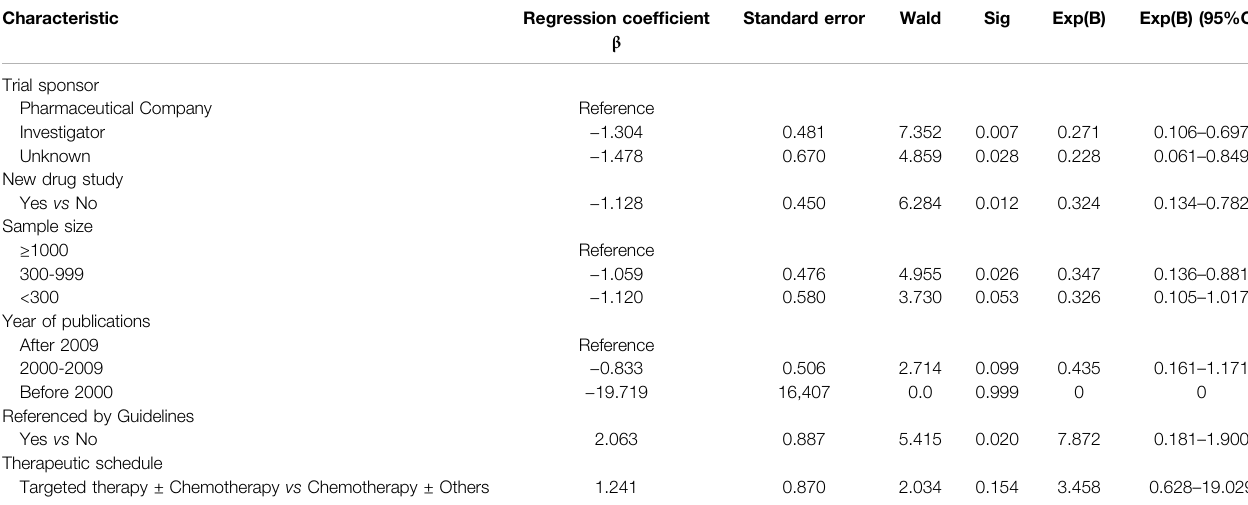
TABLE 5 | Binary logistic regression analysis of in fl uencing factors of SAEs reporting.